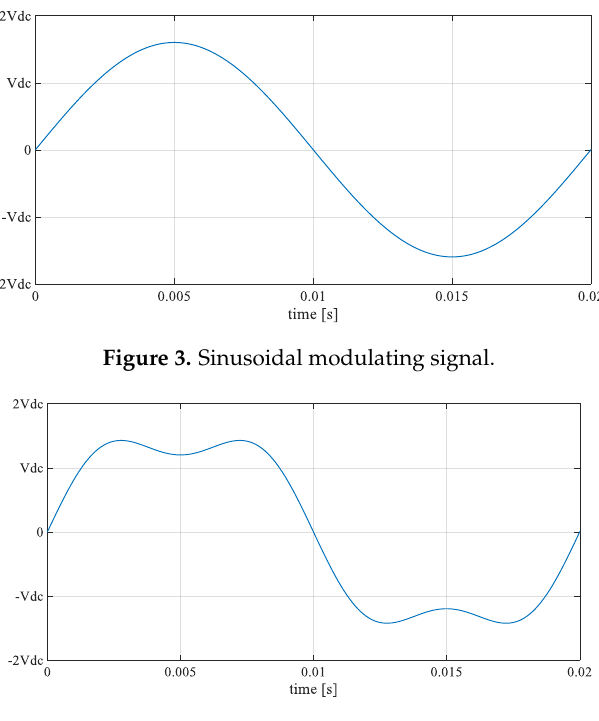
Figure 2. Multicarrier modulation techniques for five-level inverter. ( a ) Sinusoidal Phase Disposition (SPD). ( b ) Sinusoidal Phase Opposition Disposition (SPOD). ( c ) Sinusoidal Alternative Phase Opposition Disposition (APOD). ( d ) Sinusoidal Phase-Shifted (SPS).